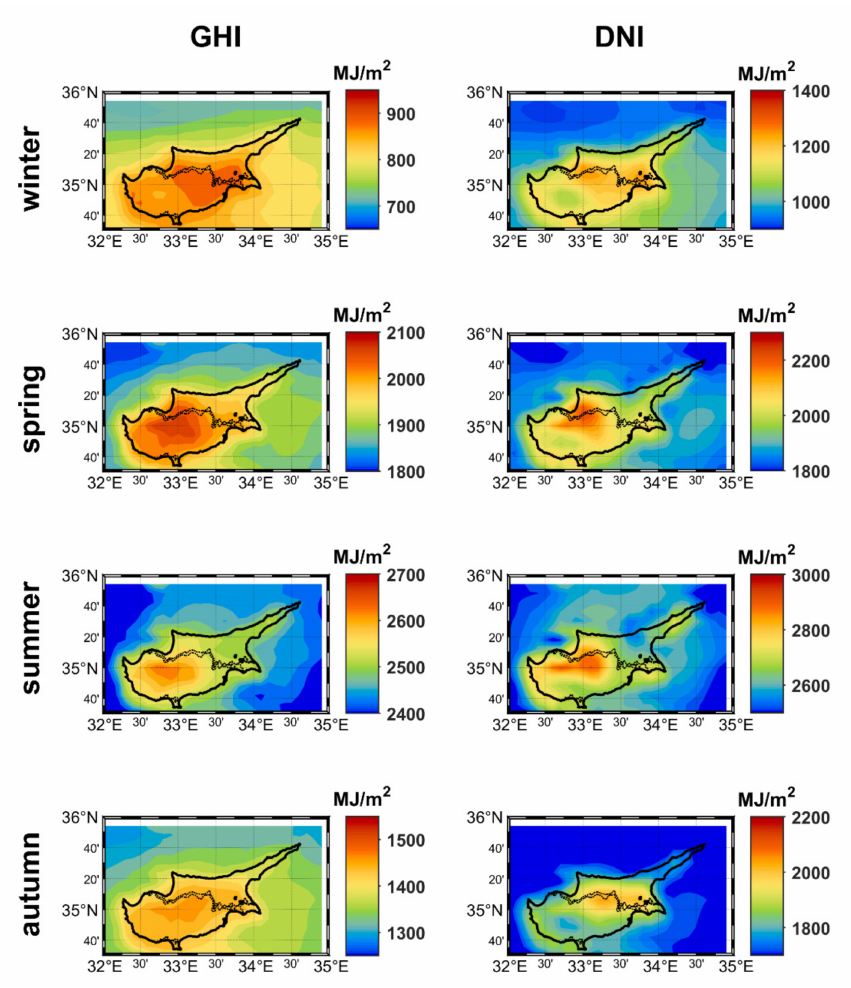
Figure 8. Total seasonal all-sky GHI and DNI.